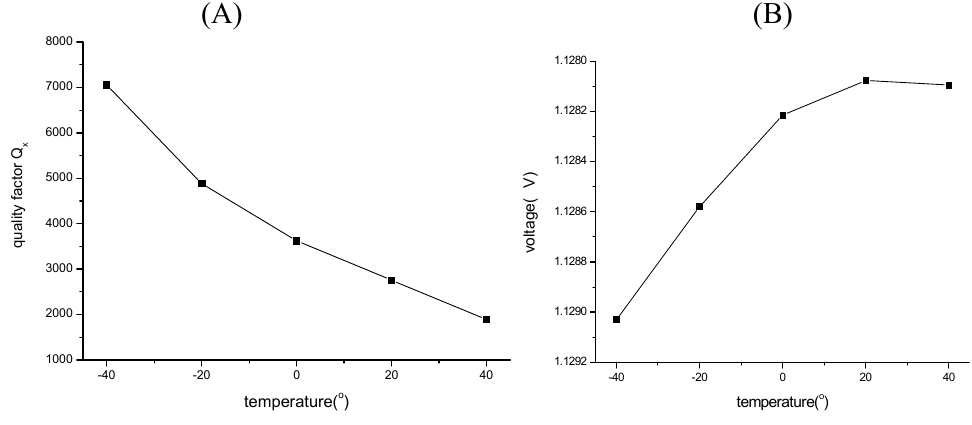
Figure 12. The experiment results of amplitude control with temperature. (A) The curve of with temperature. (B) The signal amplitude of the quality factor of the drive-mode Q x closed loop driving with